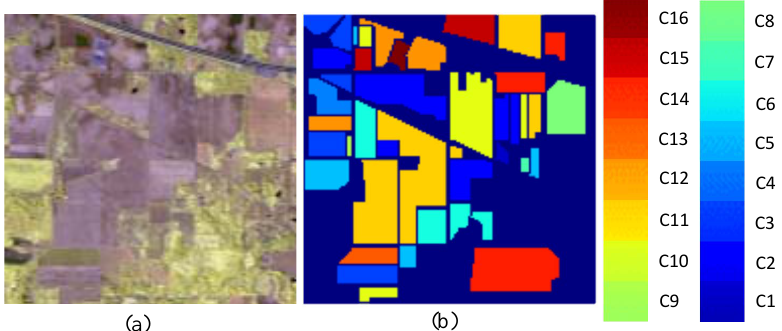
Figure 5. Indian Pines scene dataset. ( a ) false-color composite of the Indian Pines scene; ( b ) ground truth map containing 16 mutually exclusive land cover classes.